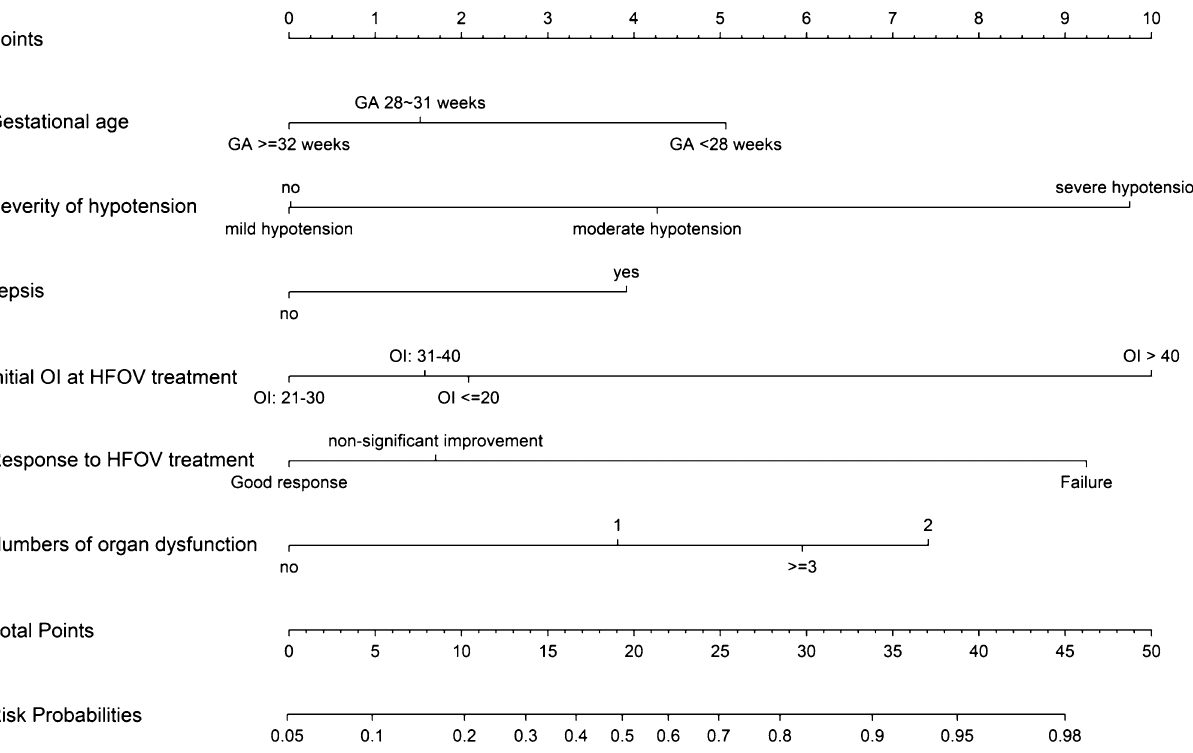
Figure 2. Multivariate stepwise logistic regression-based nomogram to predict the probability of in-hospital mortality for neonates with severe refractory respiratory failure using the following six predictors: gestation age, severity of hypotension, sepsis, initial OI at HFOV treatment, response to HFOV treatment and numbers of organ